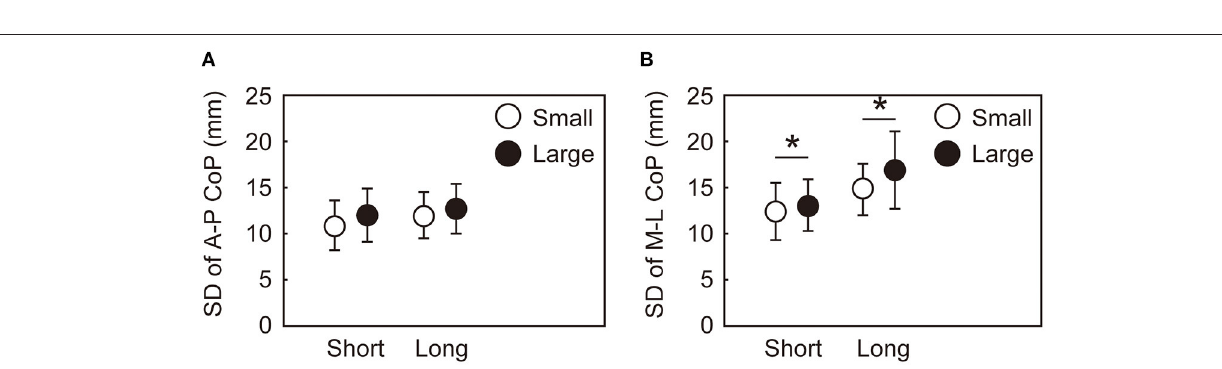
FIGURE 5 | CoM position and velocity at takeoff of the leading leg. (A) CoM position. The locations of the circles indicate the average CoM position for each condition. The error bars indicate the between-participant standard deviations. (B) CoM velocity. The length of the arrows indicates the CoM velocity for each condition, and the size of the head of the arrows indicates the between-participant standard deviations. The starting point of the arrows indicates the CoM position (equivalent to A ). *Indicates a significant difference in the CoM velocity ( p < 0.025).